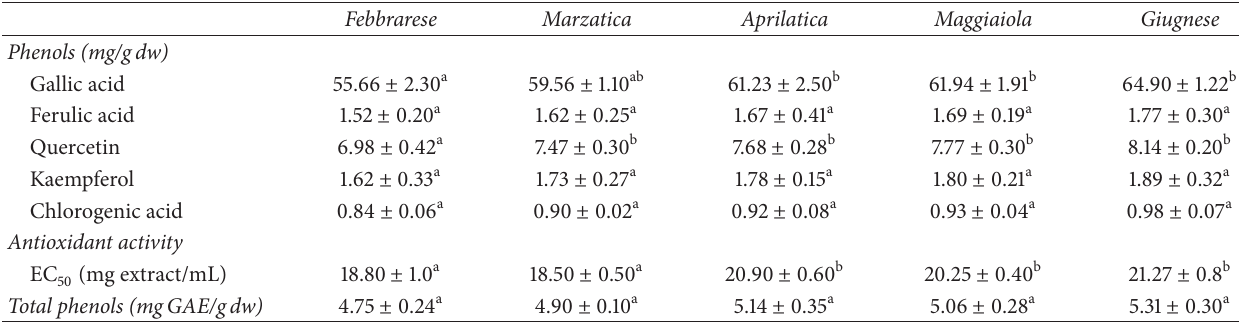
Table 2: Phenols (mg/gdw; mean ± SD), antioxidant activity (EC 50 mg extract/mL; mean ± SD), and total phenols (mg GAE/g dw) of Bianca di Pompei onion landraces.